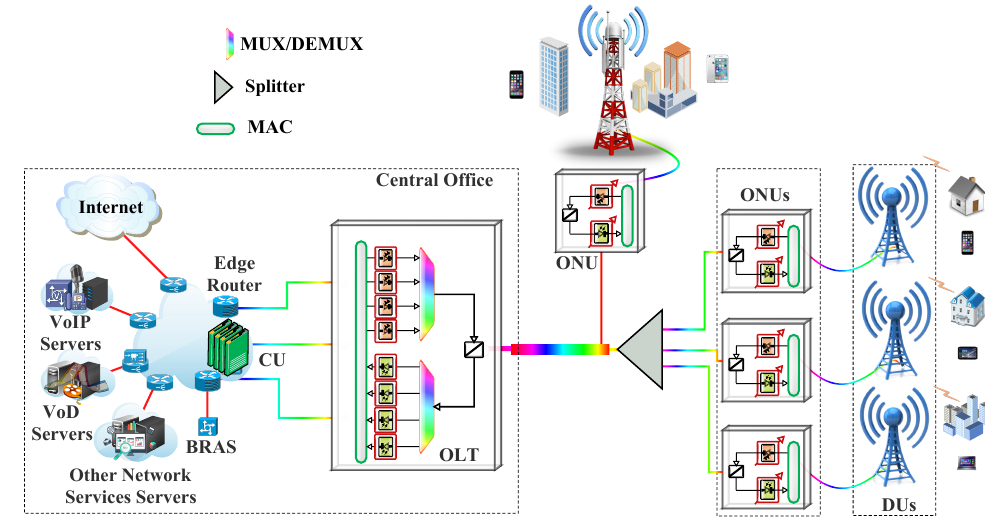
Figure 24. A typical PON-based transport network architecture for